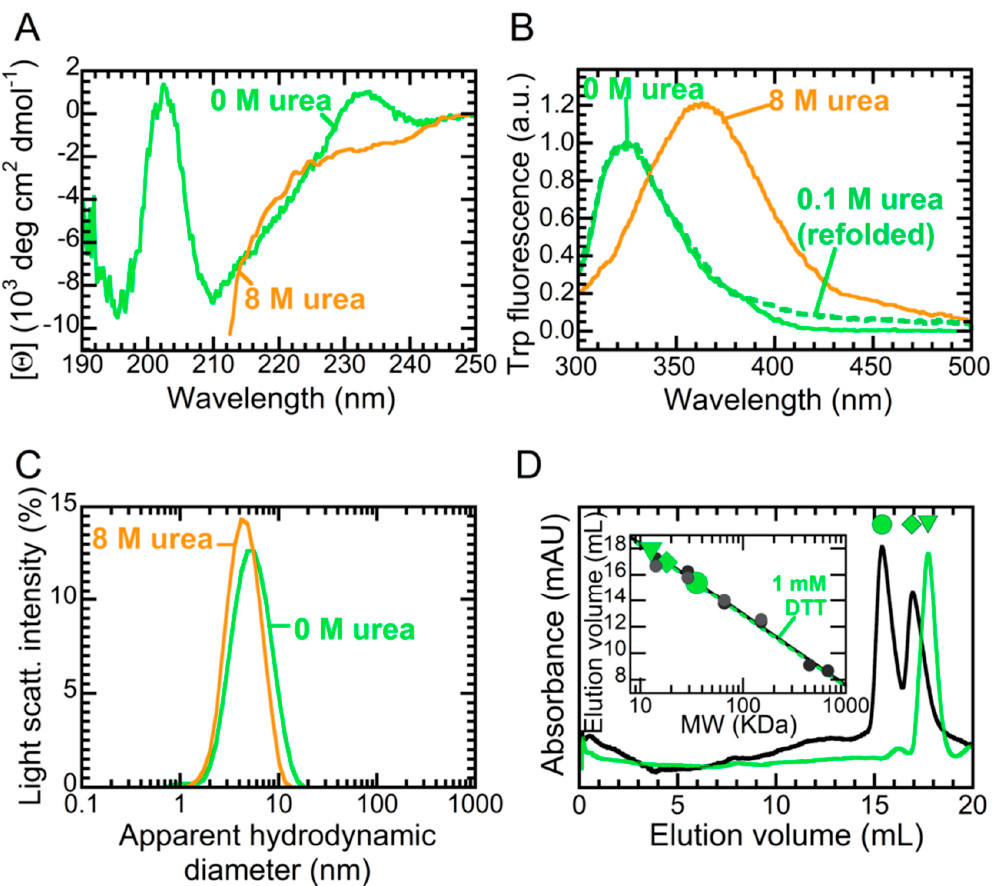
Figure 2. CD ( A ), tryptophan fluorescence ( B ), DLS ( C ) and analytical gel filtration analysis ( D ) of NTD in the absence (green) and presence of 8.0 M urea (orange). In panel B , we normalized the fluorescence signal to the maximum emission measured in the absence of the denaturant. Continuous and dashed lines refer to the folded and refolded state, respectively. In panel D , we reported data in the absence (black continuous line) and presence (green dashed line) of 1 mM DTT. The inset shows the calibration curves obtained with proteins of known mass in the absence (black continuous) and presence (green dashed) of 1 mM DTT.